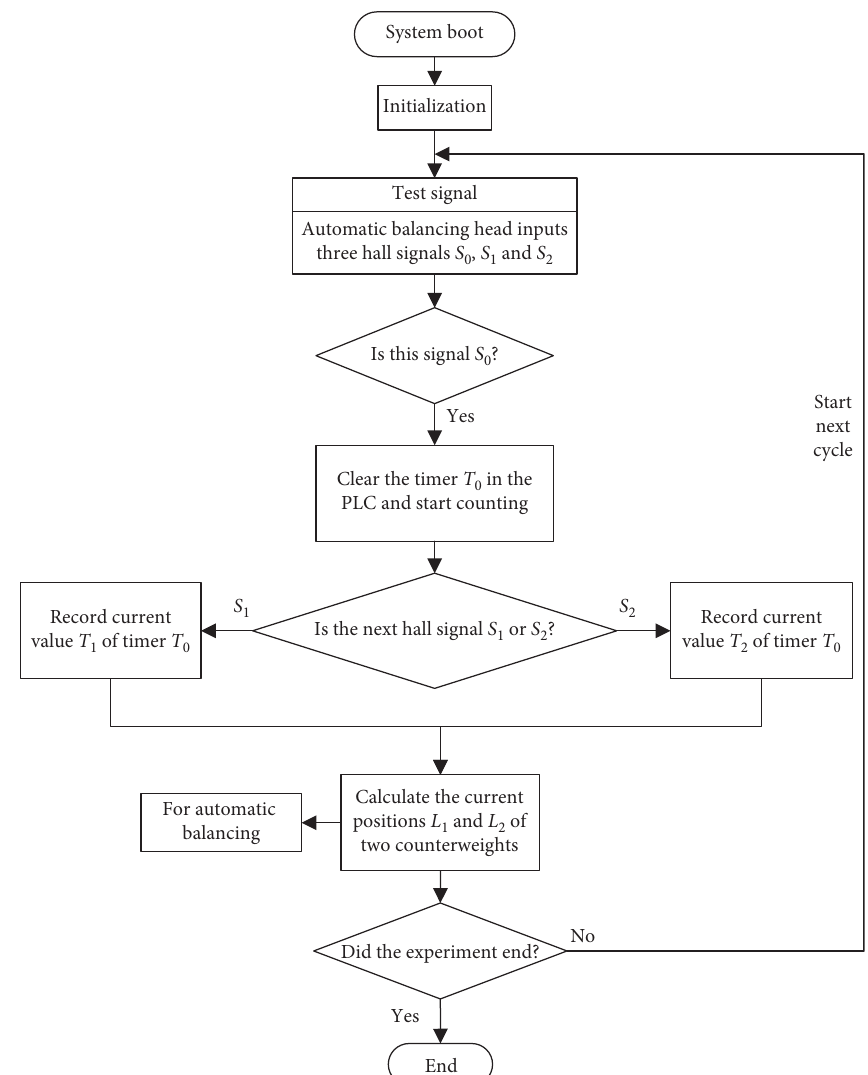
0 represents the signal of the reference Hall, S 1 represents the Hall